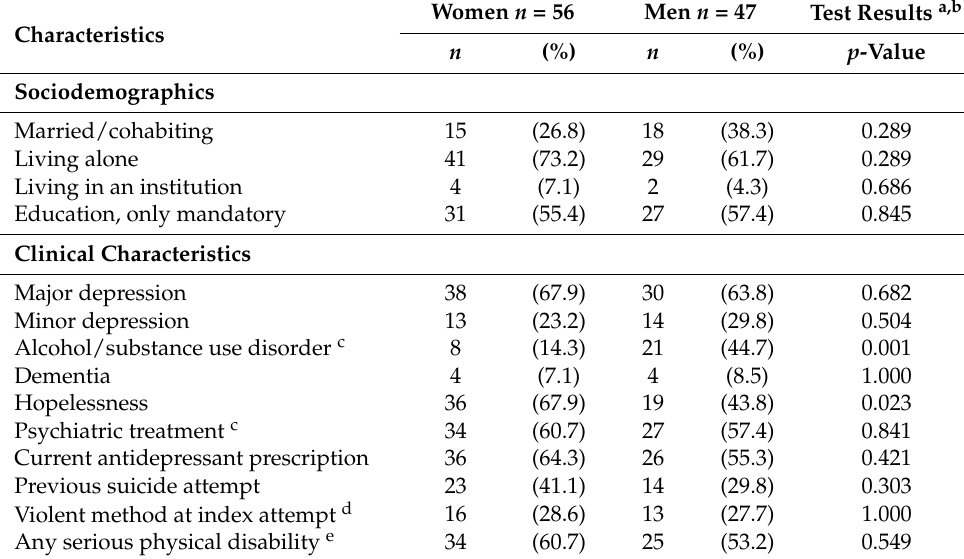
Table 1. Sociodemographic and clinical characteristics of hospitalized suicide attempters aged 70 and above, by sex.